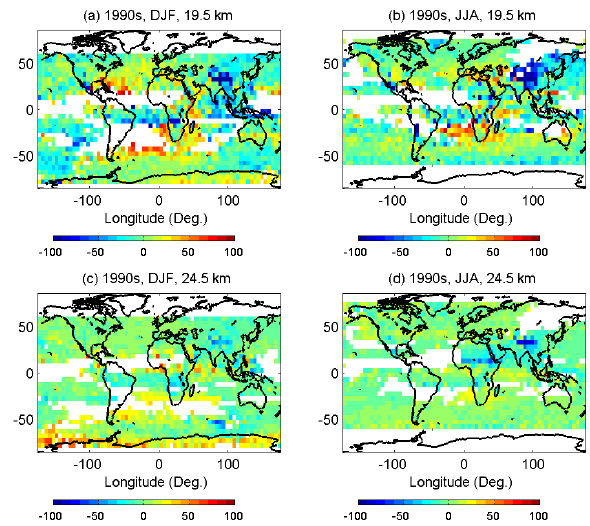
Fig. 7. Relative difference in ozone mixing ratio between the ozone climatology and SAGE data in NH winter (DJF, left panels) and summer (JJA, right panels) in the 1990s at 19.5 km (upper panels) and 24.5 km (lower panels). The comparison is made when both datasets are available at a cell and is expressed as the percentage difference of climatology minus SAGE divided by their mean.